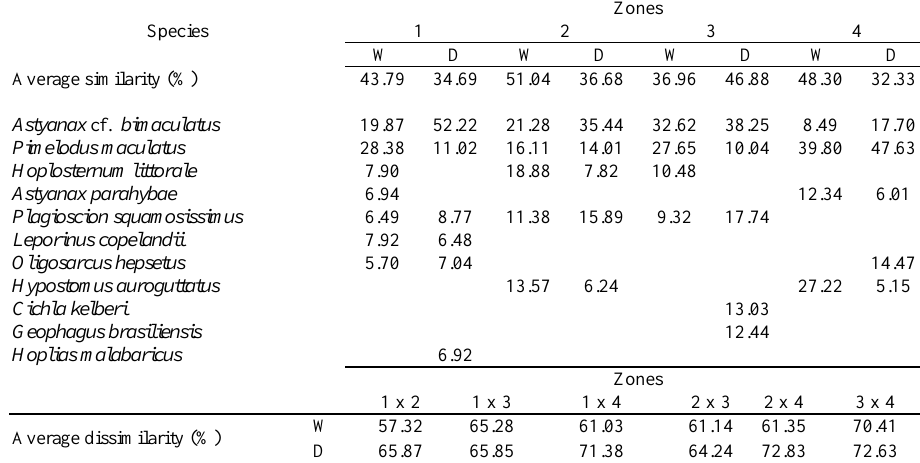
Table 2. Percent contribution of the most abundant species to similarity within the zones and dissimilarity between the zones. W = Wet season; D = Dry season.